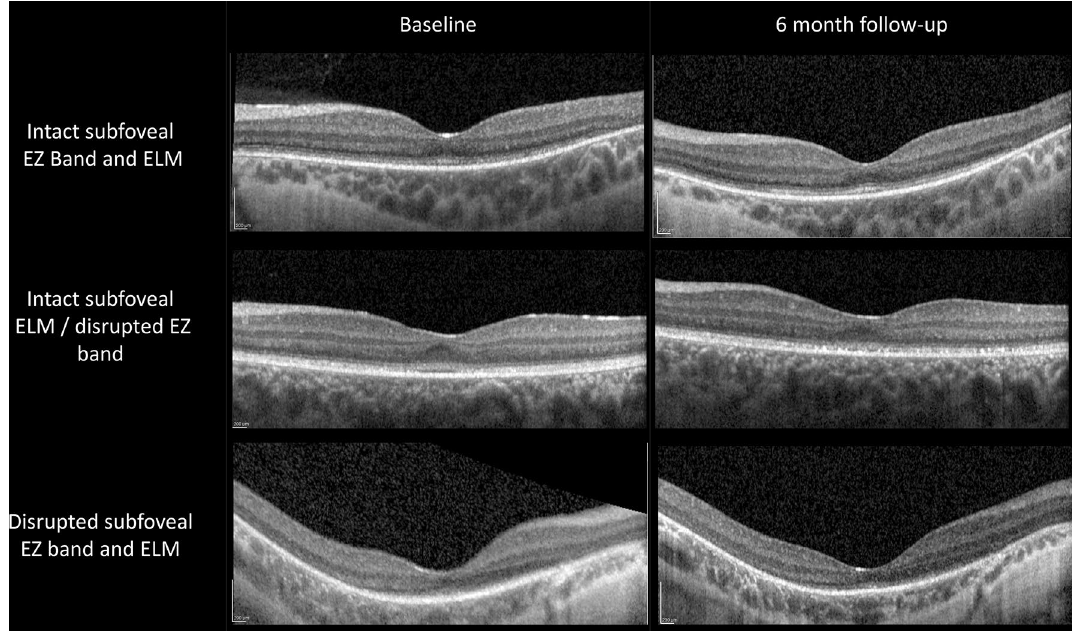
Figure 1. Spectral-domain optical coherence tomography (SD-OCT) scans at the baseline and at the six-month follow-up in three selected cases, showing no significant changes in qualitative evaluation after treatment with